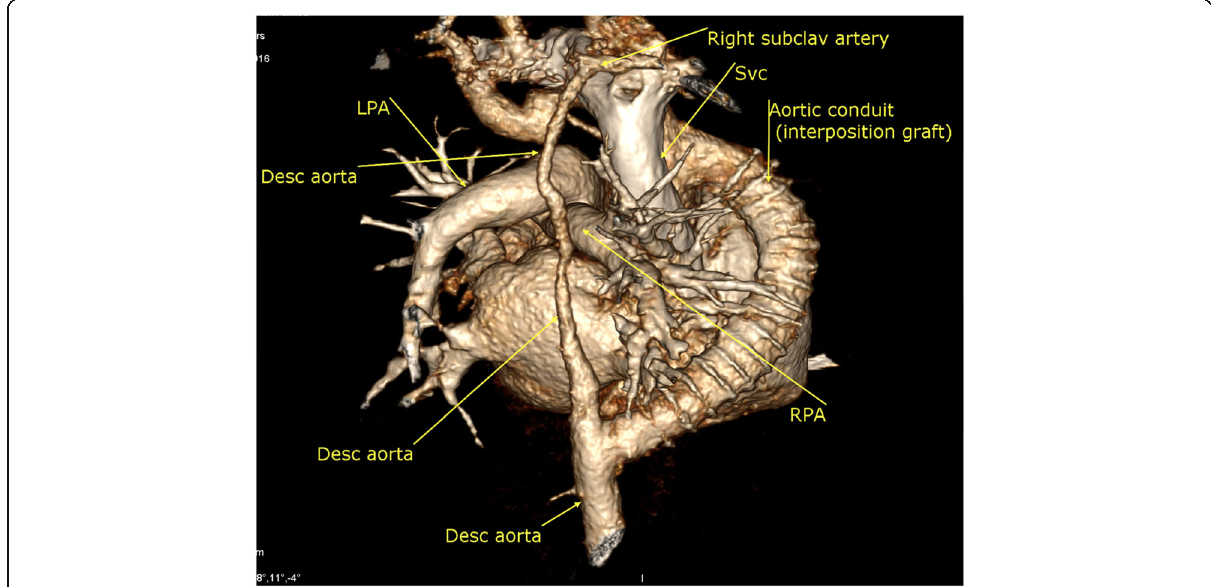
Fig. 4 3D volume rendering image showing the aortic inter-position graft and the long segment of descending aorta hypoplasia from the posterior